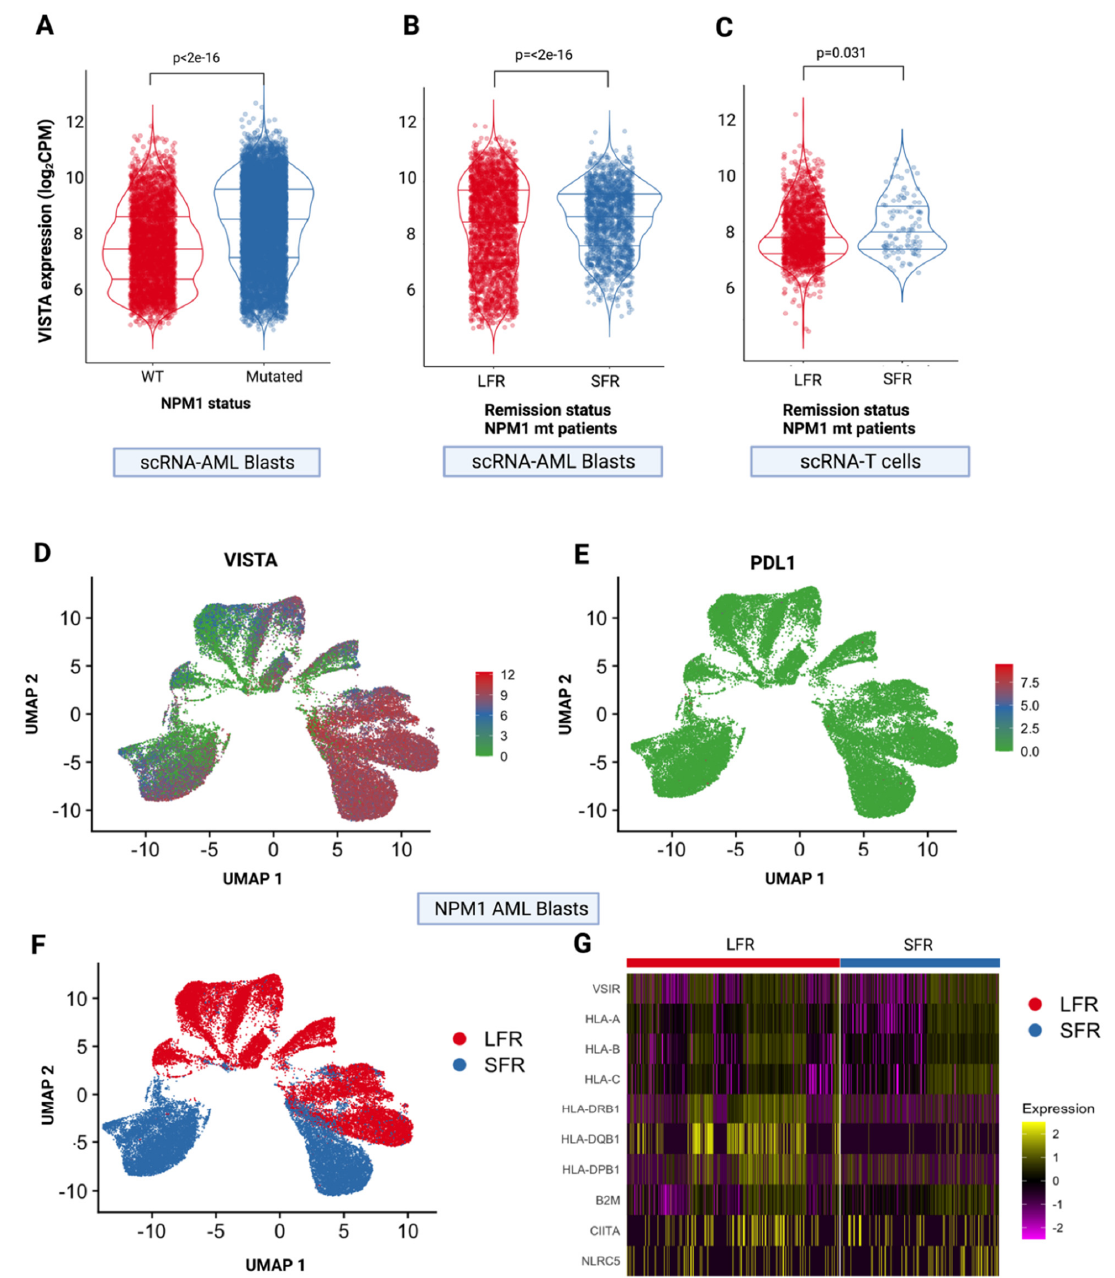
Figure 4. VISTA expression at single cell level. ( A ) VISTA expression in single-cell RNAseq samples from isolated AML blasts according to NPM1 mutational status. ( B ) VISTA expression in single-cell RNAseq samples of AML blasts from patients with NPM1 mutations according to the length of first remission (long, LFR , >5 years vs. short , SFR , <2 years). ( C ) VISTA expression in single-cell RNAseq samples of T cells from patients with NPM1 mutations according to first remission status (long, LFR , >5 years vs. standard , SFR , <2 years). ( D ) Uniform manifold approximation and projection for dimension reduction (UMAP) of VISTA and ( E ) PDL-1 expression in AML cells from NPM1 -mutated patients (N = 9 single-cell RNAseq samples). Each dot represents a cell; gray dots indicate low or null expression. The purple gradient indicates the intensity of each gene expression (VISTA on the left and PDL1 on the right). ( F ) UMAP showing the distribution of AML cells in LFS and SFR groups. ( G ) Heatmap showing the difference in expression of VISTA, HLA genes and HLA class I and II transactivators between LFR and SFR